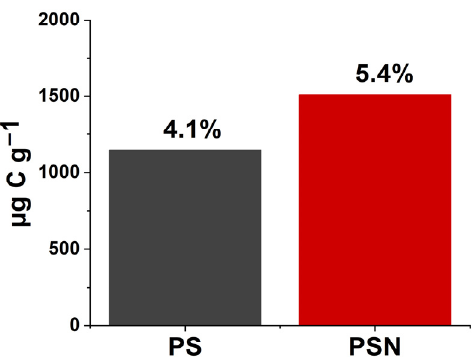
Figure 5. Cumulative amount of plastic-originated C mineralized to CO 2 . The values above the bars correspond to the percent of respired C in relation to the added C with correspond to the percent of respired C in relation to the added C with PBSA.